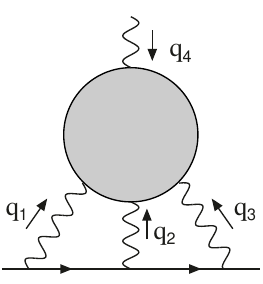
Figure 1 . HLbL contribution to the ( g